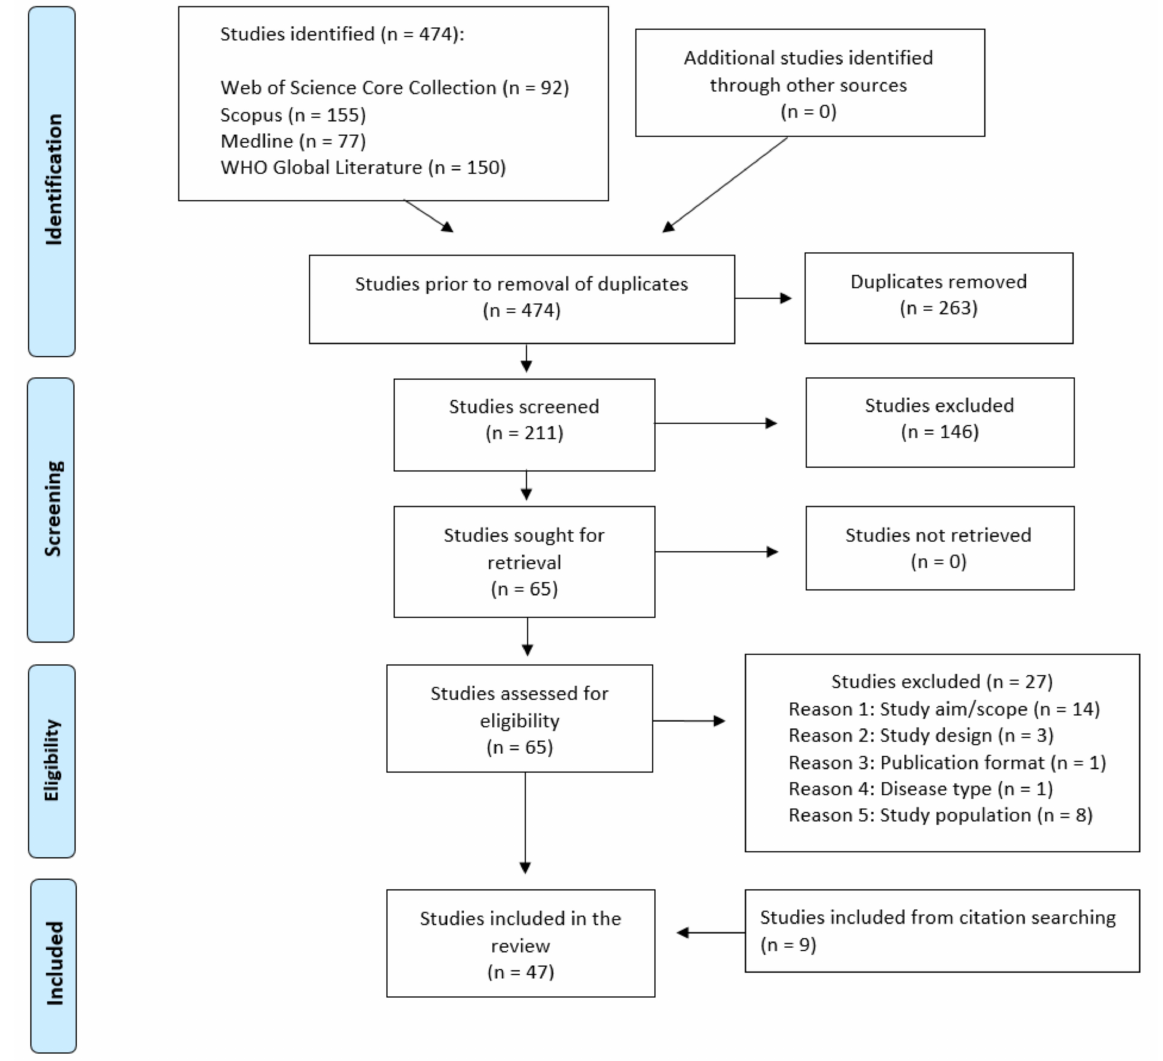
Figure 1. Flow diagram of included studies and reasons for